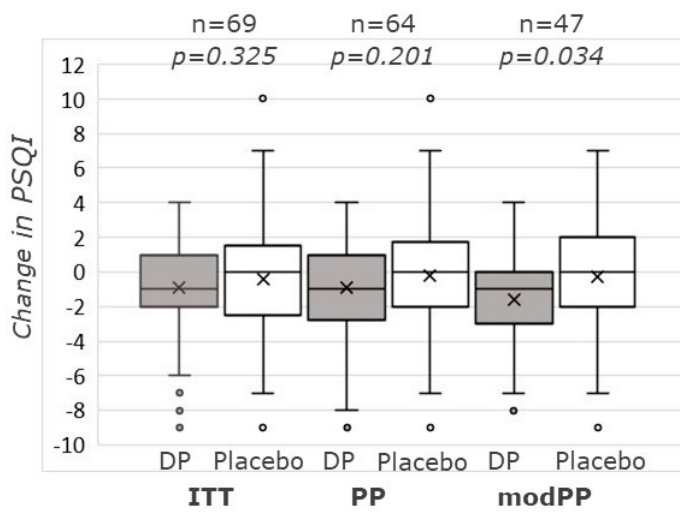
Figure 2. Changes in PSQI from baseline to day 14, for the ITT, PP, and modPP populations. Box- Whisker plot showing median, first (Q1) and third (Q3) quartile, and mean value (X). Whiskers are 1.5 times inter quartile range (IQR = Q3–Q1)) or maximum/minimum values when these are within the 1.5 IQR range. Outliers (beyond the 1.5 times IQR) are presented as single dots. p -values are based on independent-samples t-test. DP: Dairy-based test product. Placebo: skimmed milk. PSQI: Pittsburgh Sleep Quality Index.